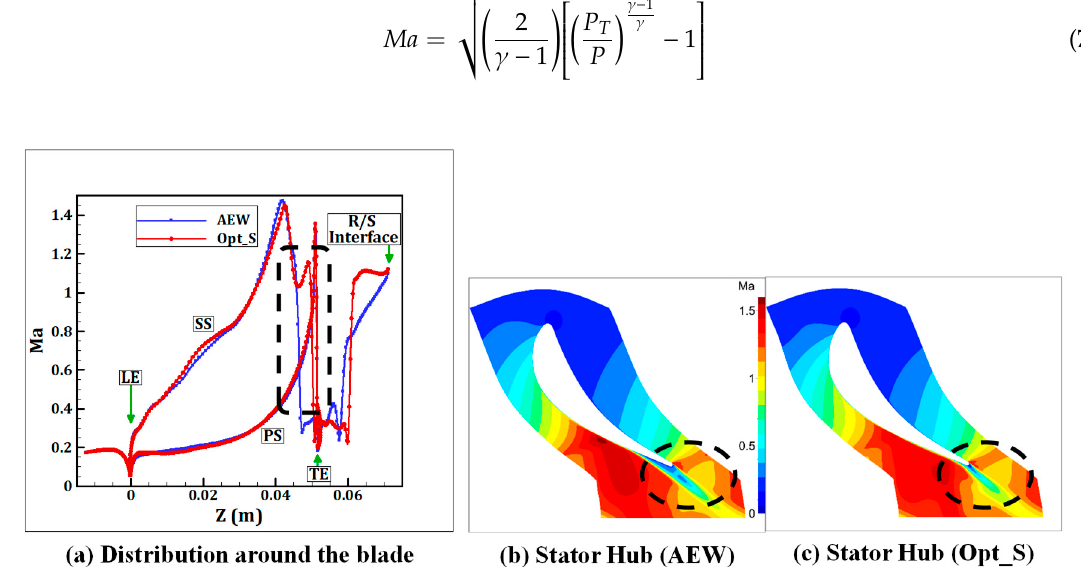
Figure 9. ( a–c ) Isentropic Mach number distributions and contours at 1% span.